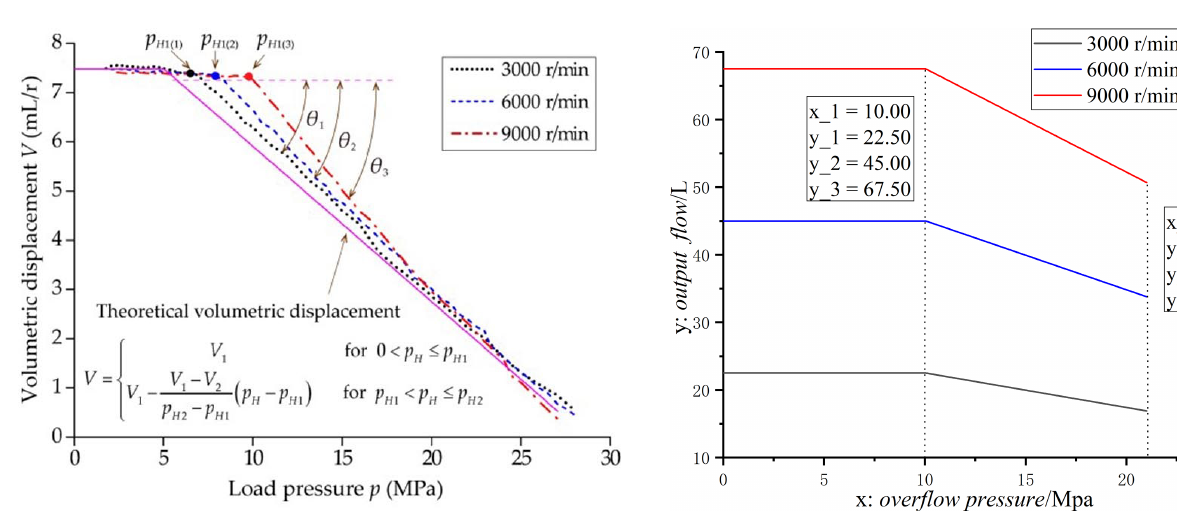
Figure 3. Comparison diagram of load pressure and volumetric dis- placement with different rotational speed.